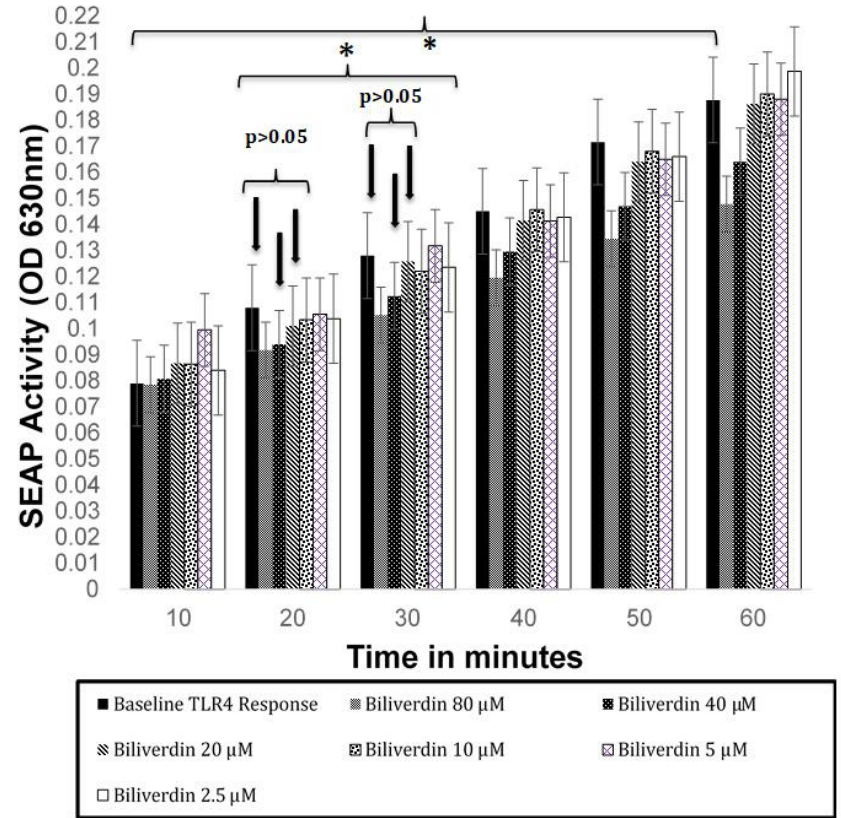
Figure 5. SEAP production by HEK-Blue TLR4 cells treated with Bv overnight. The following day, was measured at 630 nm. Because Bv is a poor TLR4 stimulant, the treatments were assayed at 10 min time intervals to assess stimulation or inhibition of innate NF- κ B activation, as measured by dependent SEAP activity. This also demonstrated that Bv concentration has no direct e ff ect on the measurement of SEAP activity. Otherwise, the cells used in these experiments were not stimulated with other TLR4 ligands and SEAP is measured as a baseline activity. Comparison of 10 min SEAP activity (QuantiBlue TM conversion; OD 630 nm) to 60 min SEAP activity demonstrated that the baseline enzyme increased at a regular rate, regardless of Bv concentration. The increase in SEAP over the entire 60 min, and between the 20–30 min time intervals, were both found to be significant by ANOVA ( p < 0.05), as shown by brackets and an asterisks (*). There were no significant di ff erences (ANOVA) between media controls and the 20 or 40 µ M Bv treated reporter cells at either the 20 or 30 min intervals (designated by arrows; p > 0.05).